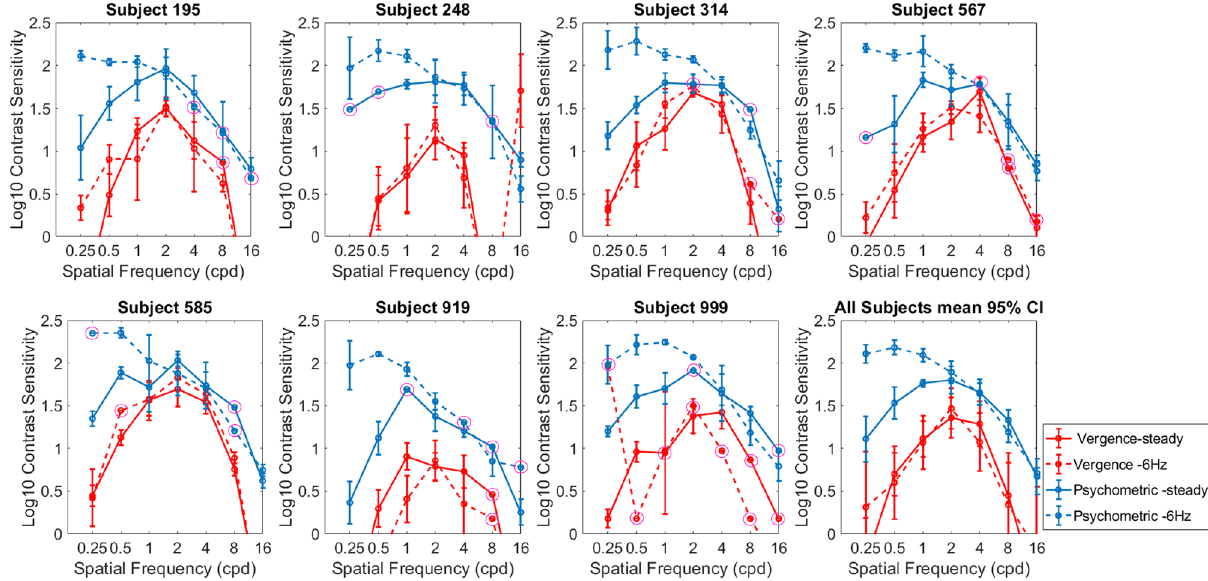
Figure 3. Comparison of vertical vergence CSFs (red) vs psychophysical CSFs (blue) at 5 arcmin disparity. The shape of the vergence CSF was similar to the psychophysical CSF, but with overall lower sensitivity. Flicker showed a strong effect at low spatial frequencies in the psychophysical data (blue dashed curves), but not in the vergence data (red dashed curves).